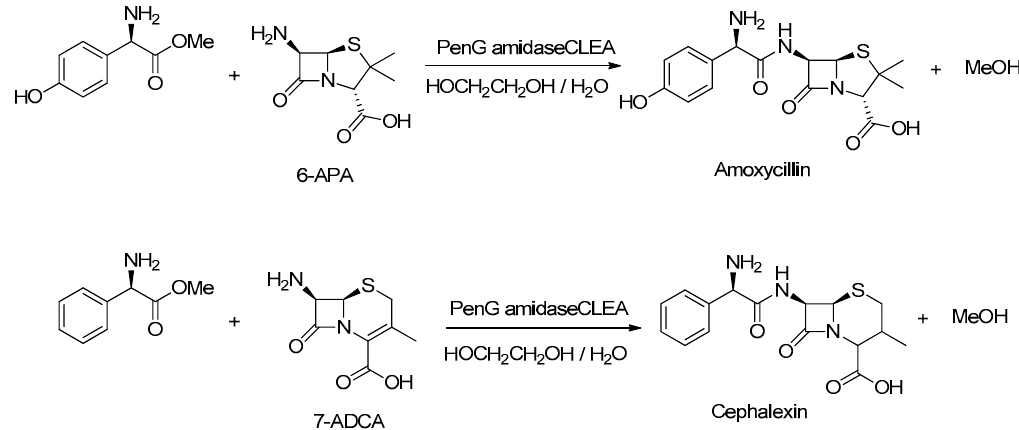
Figure 14. Enzymatic synthesis of penicillins and cephalosporins.